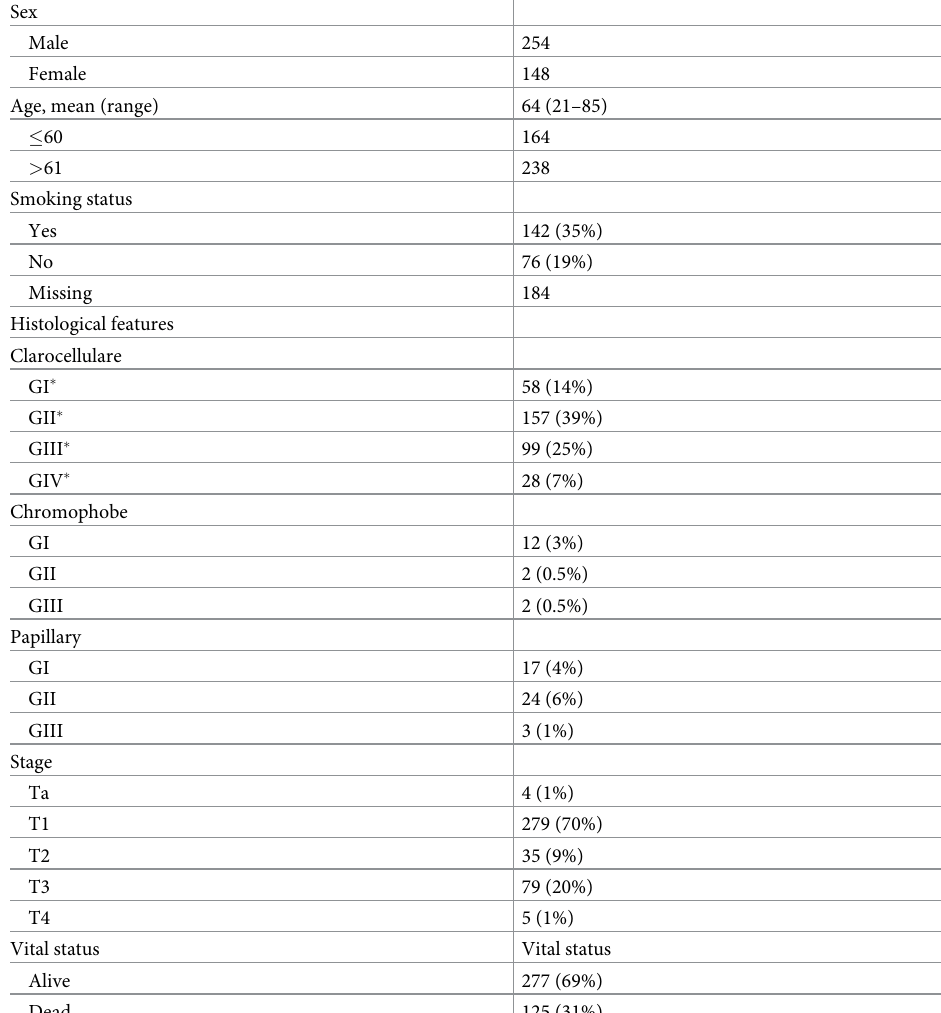
Table 4. Characteristics of the study population of kidney cancer (n =